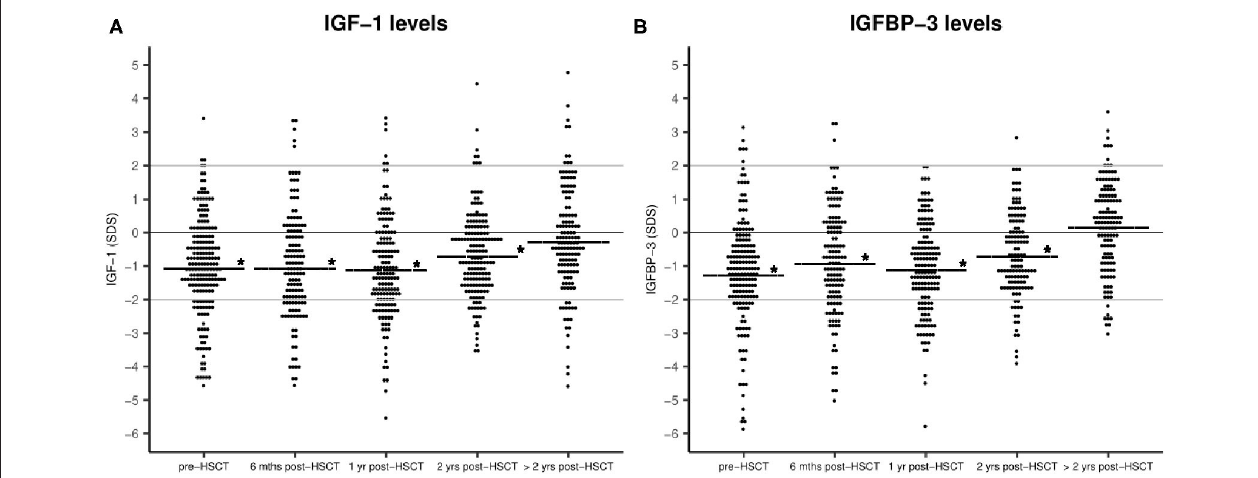
FIGURE 1 | IGF-1 (A) and IGFBP-3 (B) plasma levels before and after HSCT as sex- and age-adjusted SD-scores. Horizontal line: mean IGF-1/IGFBP-3 SDS. Statistical evaluation indicates IGF-1 and IGFBP-3 levels compared with healthy population (0 SDS), * P < 0.001. No. of patients = 172.